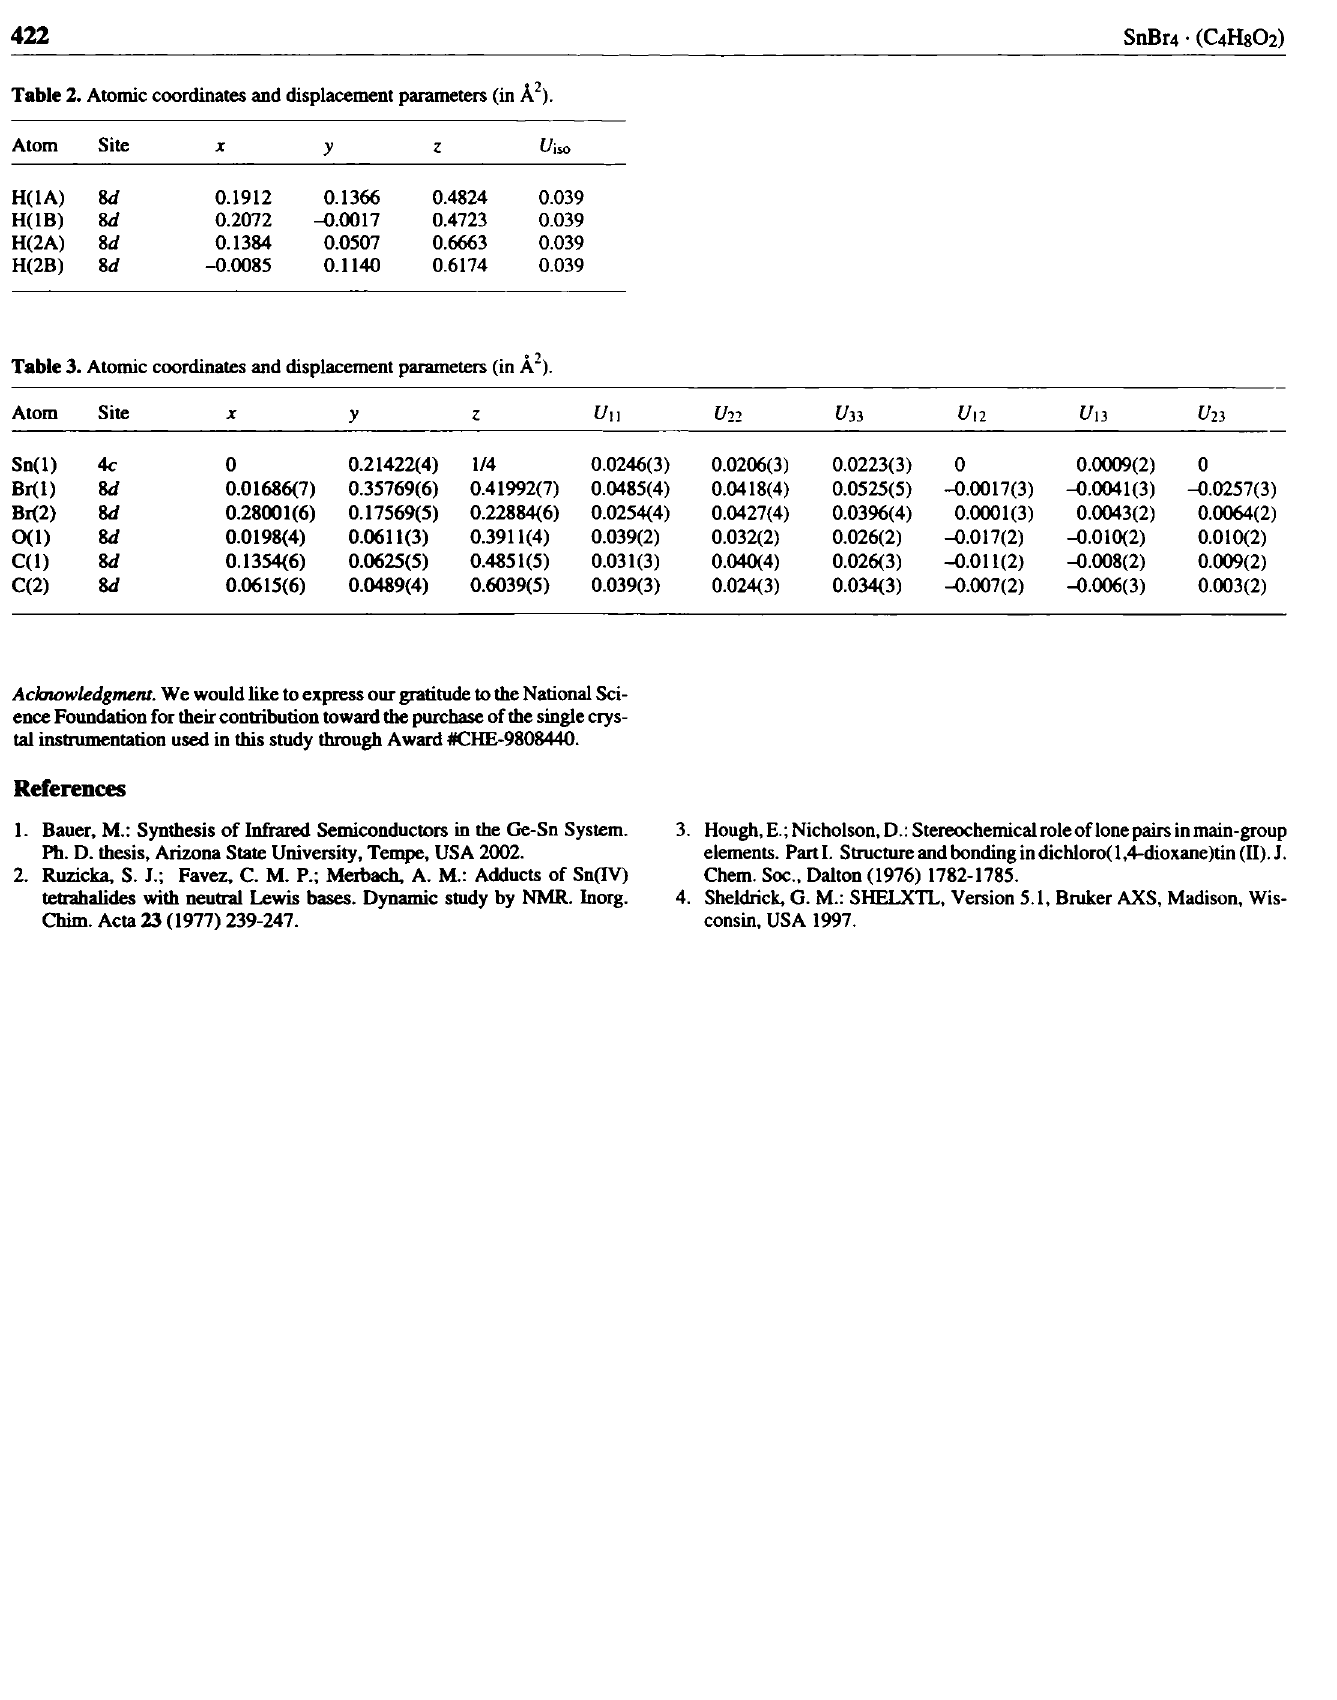
Table 2. Atomic coordinates and displacement parameters (in A 2 ).